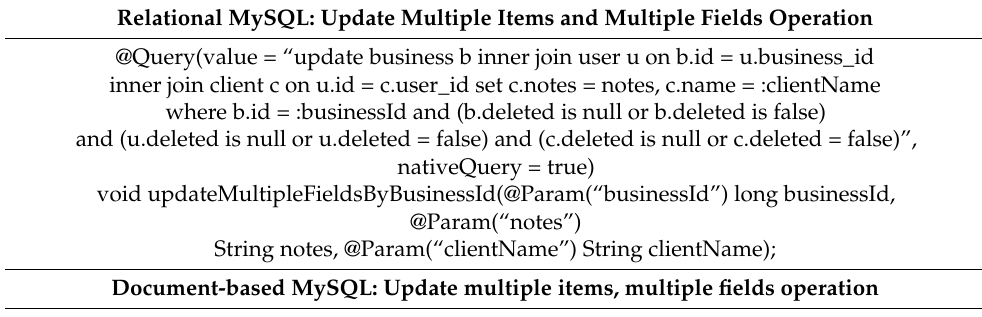
Table 7. Update multiple items and multiple fields operation.